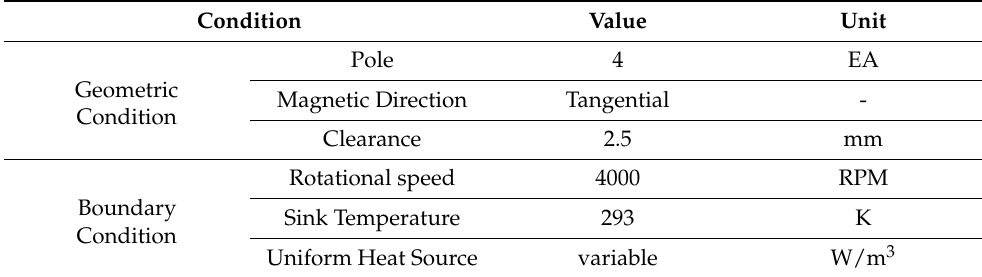
Table 2. Boundary conditions for numerical analysis